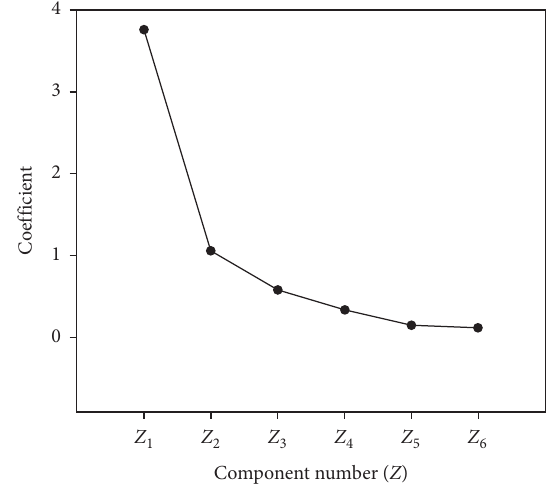
Figure 3: The coefficient of principal components.